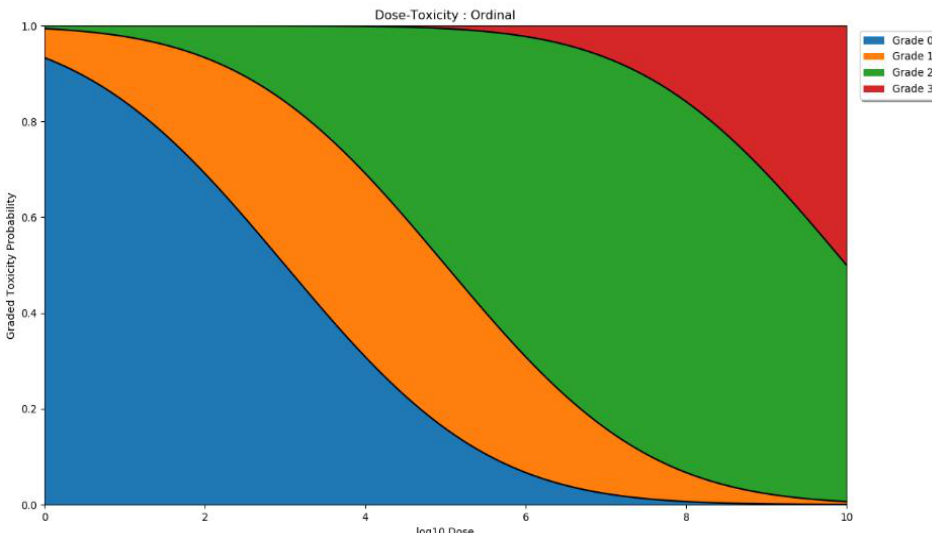
Figure 4. Visual example of ordinal dose toxicity. The plot shows the proportion of individuals that would experience different adverse event grades for each dose. In this example, at low doses, grade 0 (blue) adverse events are most likely. By dose 6, grade 1 (yellow) and grade 2 (green) adverse events are likely but grades 0 and 3 are also possible. By the maximum dose, approximately 50% of individuals would experience a grade 3 adverse event, and almost all others would experience grade 2